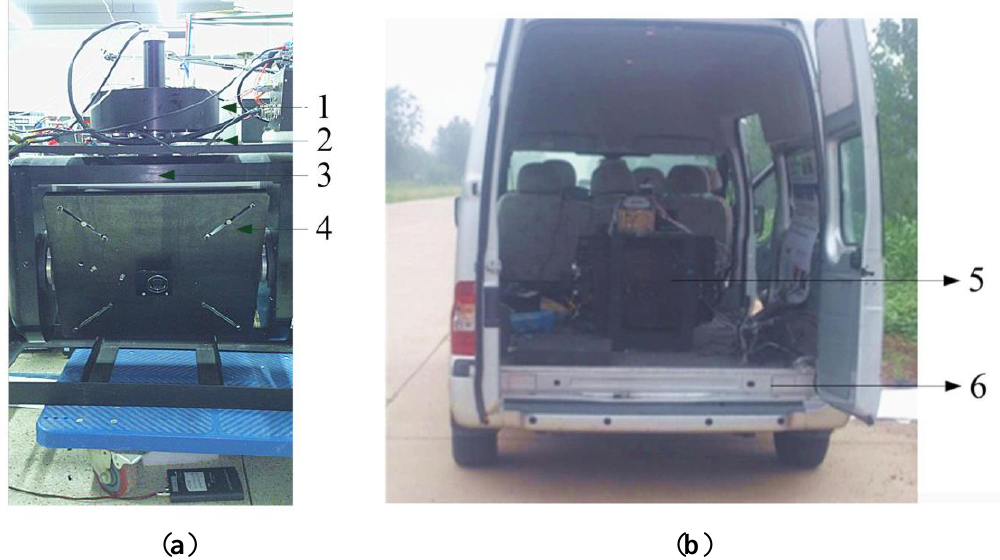
Figure 19. Picture of the ISP during experiments under movable base conditions: ( a ) ISP and ( b ) movable vehicle. 1-Loads; 2-Base; 3-Azimuth gimbal; 4-Pitch gimbal;